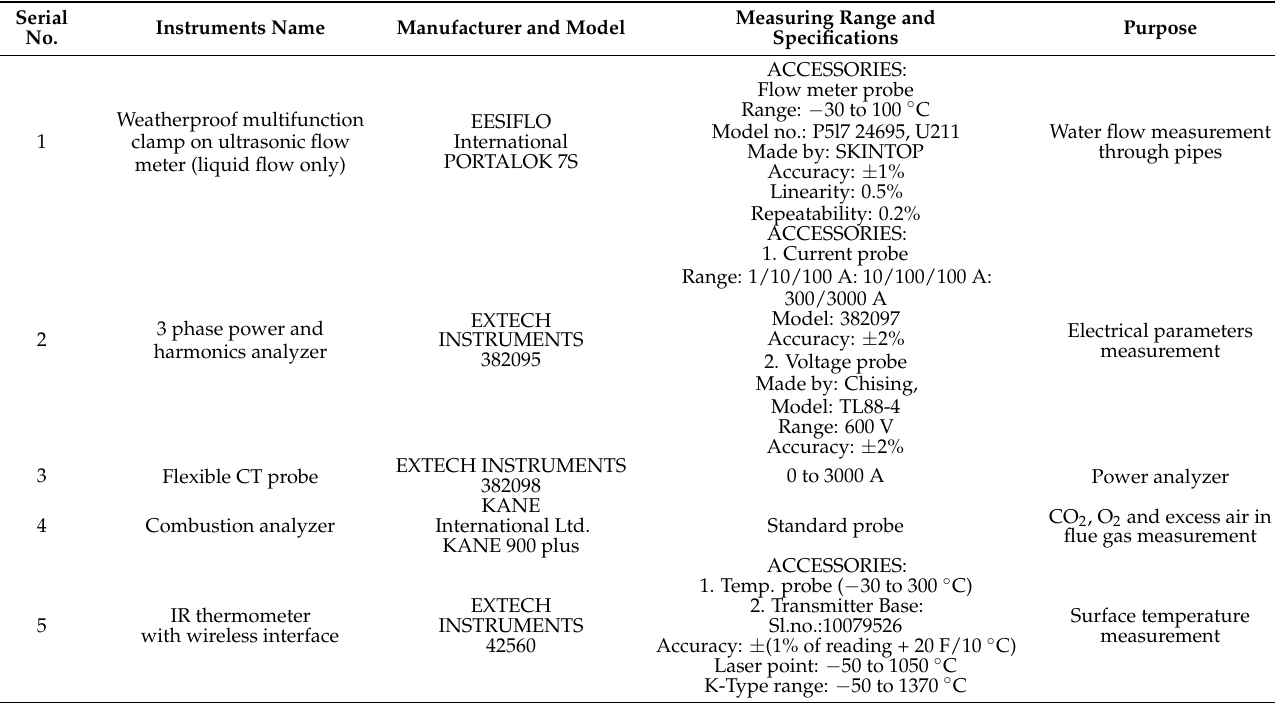
Table 3. List of the equipment and their specifications used in the audit. Serial